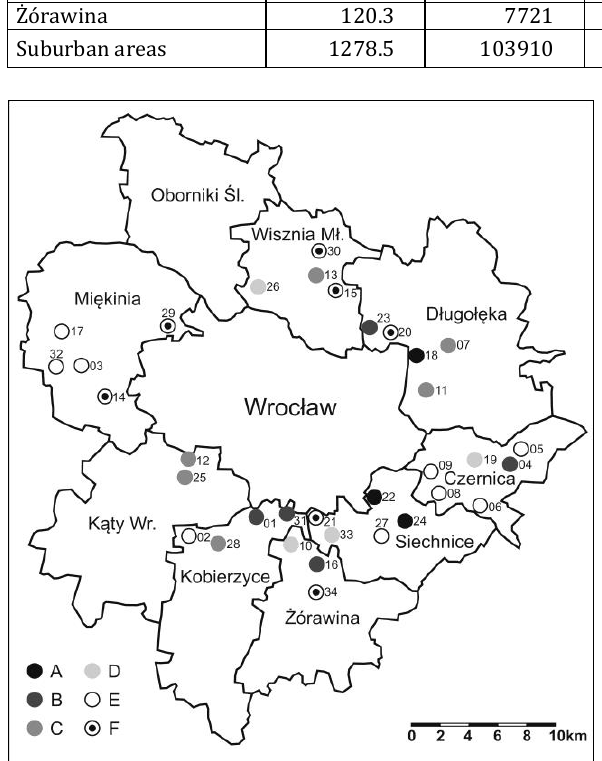
Fig. 1. Settlements in the suburban zone of Wrocław for which morphological changes were